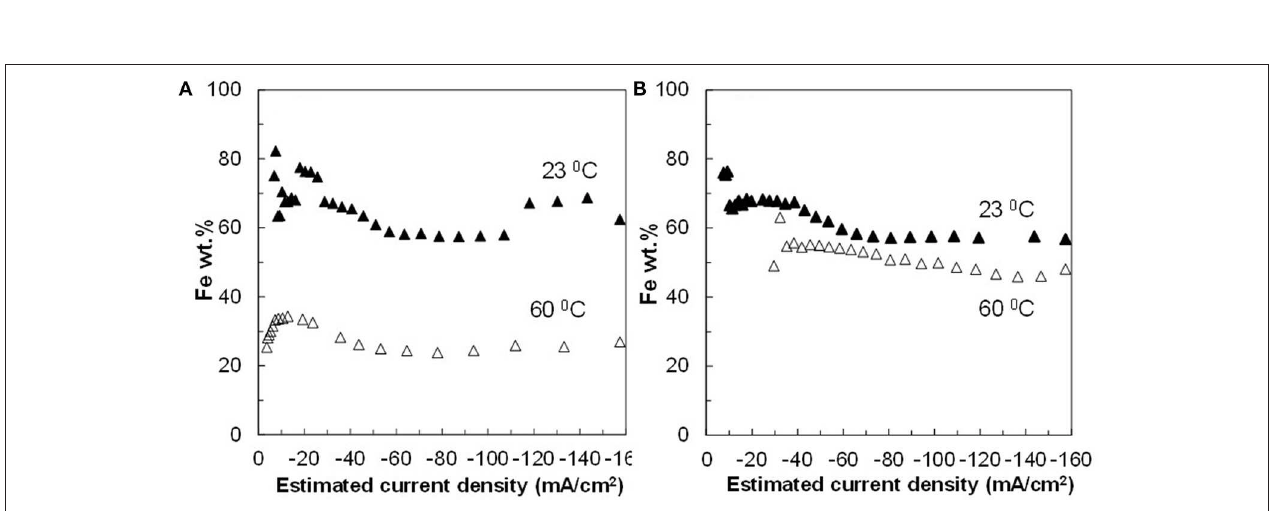
FIGURE 4 | Fe concentration in Fe–Co–W alloy films at two different temperatures 23 and 60 ◦ C, and at an electrode rotation rate of (A) 300 and (B) 600 rpm.